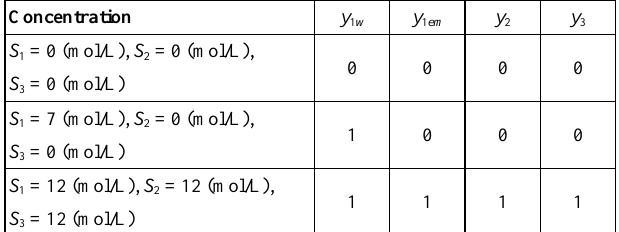
Fig. 12. The curve of control system with F1 = 10 and k 1 = 2. The curve of x out with F1 = 20 and the function of adapter1 W adapt1 = k 1 = 2 is shown in Fig. 13.